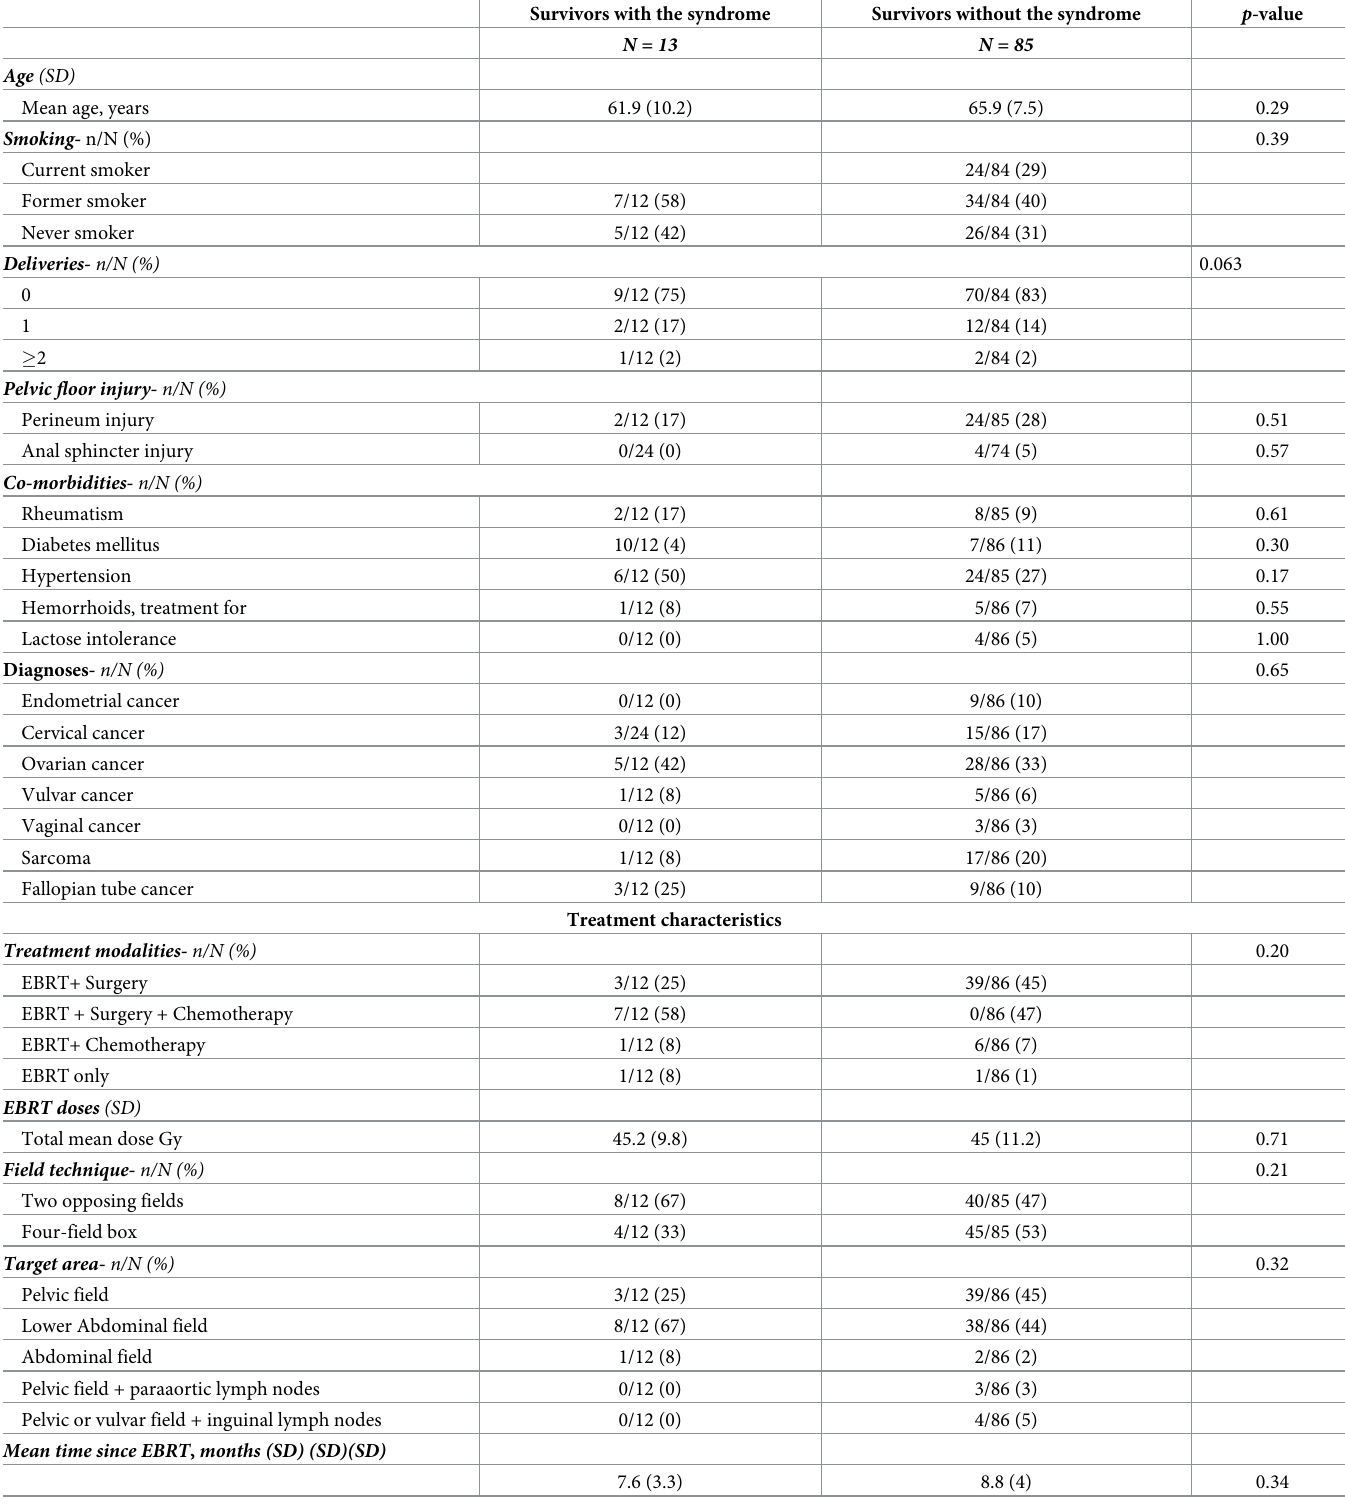
Table 1. Demographic, clinical characteristics and treatment characteristics of survivors with or without ‘excessive mucus discharge’ after pelvic radiation